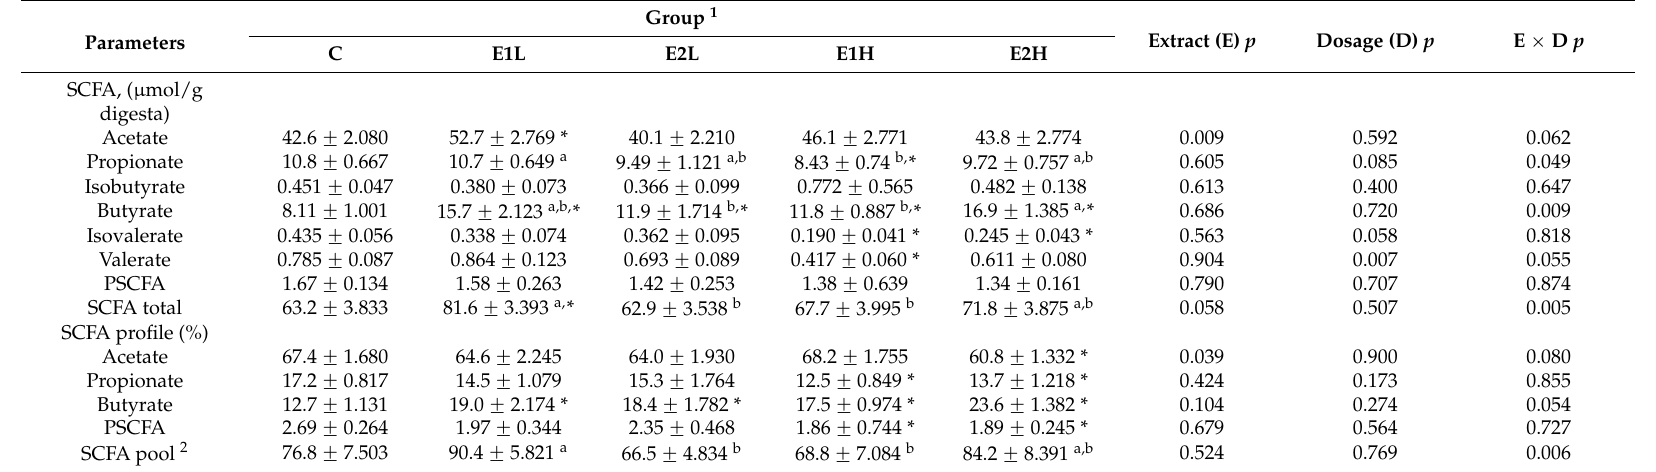
Table 3. Short-chain fatty acids (SCFA) in the caecum digesta of rats.